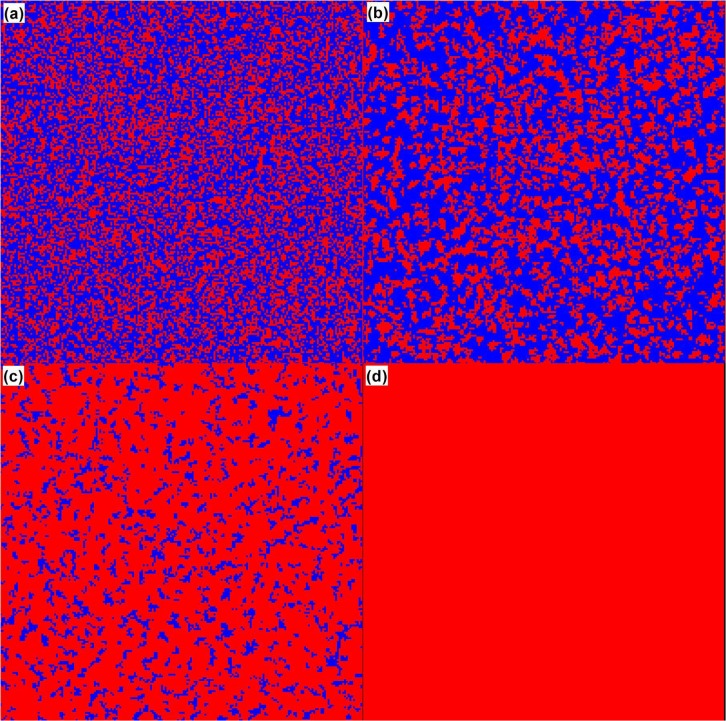
Typical snapshots of strategy distributions on the square lattice when σ = 0.5 and r = 5.Cooperators and defectors are colored red and blue, and the MCS of (a)-(d) is 1, 10, 100, 50000 respectively. The figure shows that the fraction of cooperators decreases at the beginning of the evolution, but as the evolution proceeds, the cooperators form into clusters to restrain the invasion of the defectors, and spread to the defectors reversely. At the end of the evolution all the players in the population hold the cooperation strategy.